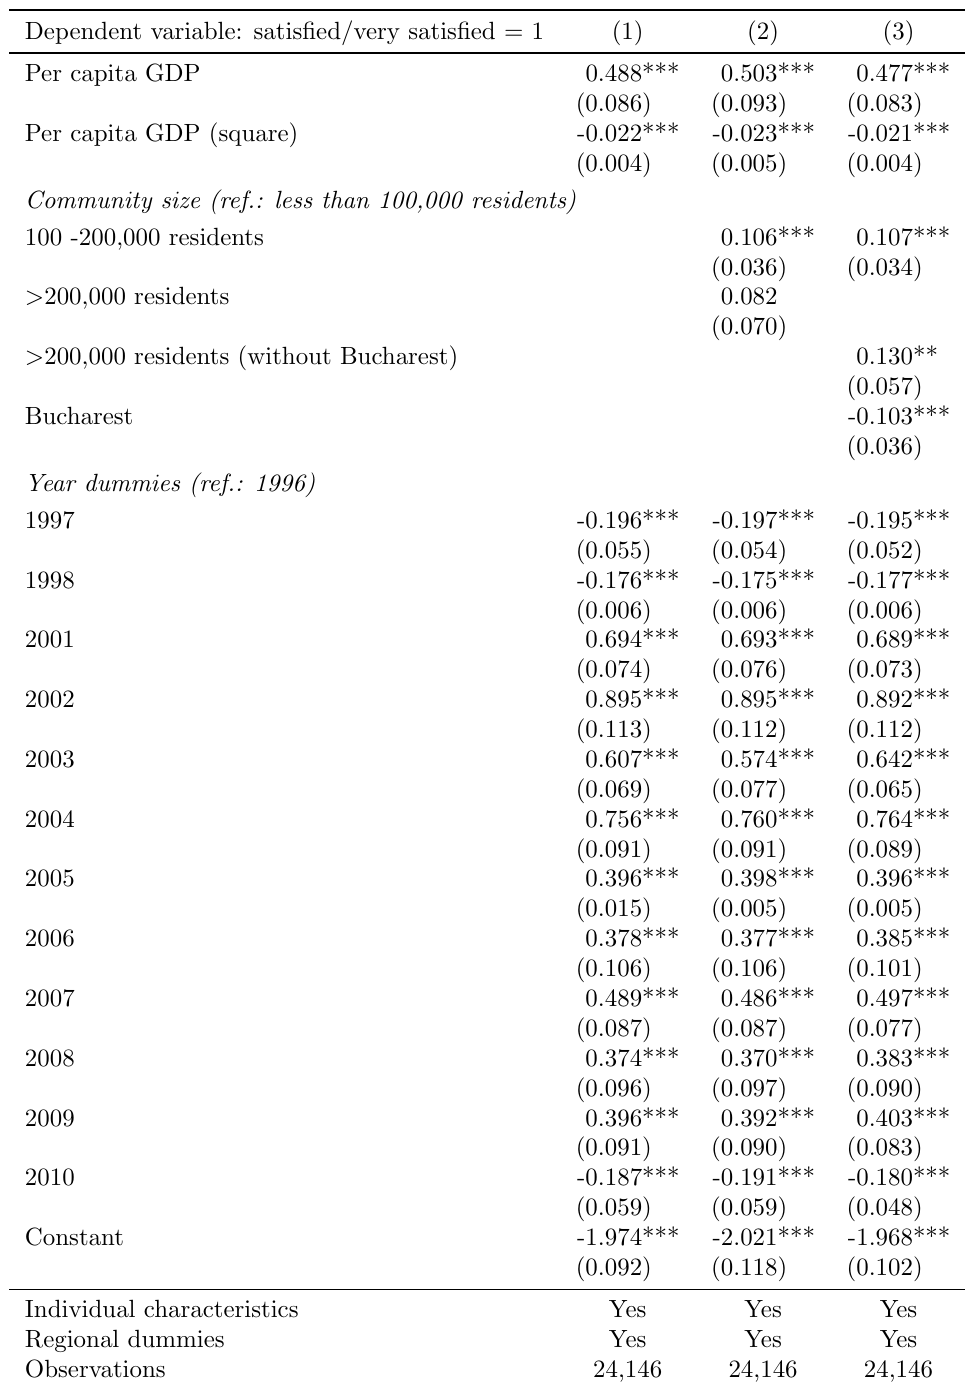
Table 2: Life satisfaction and city